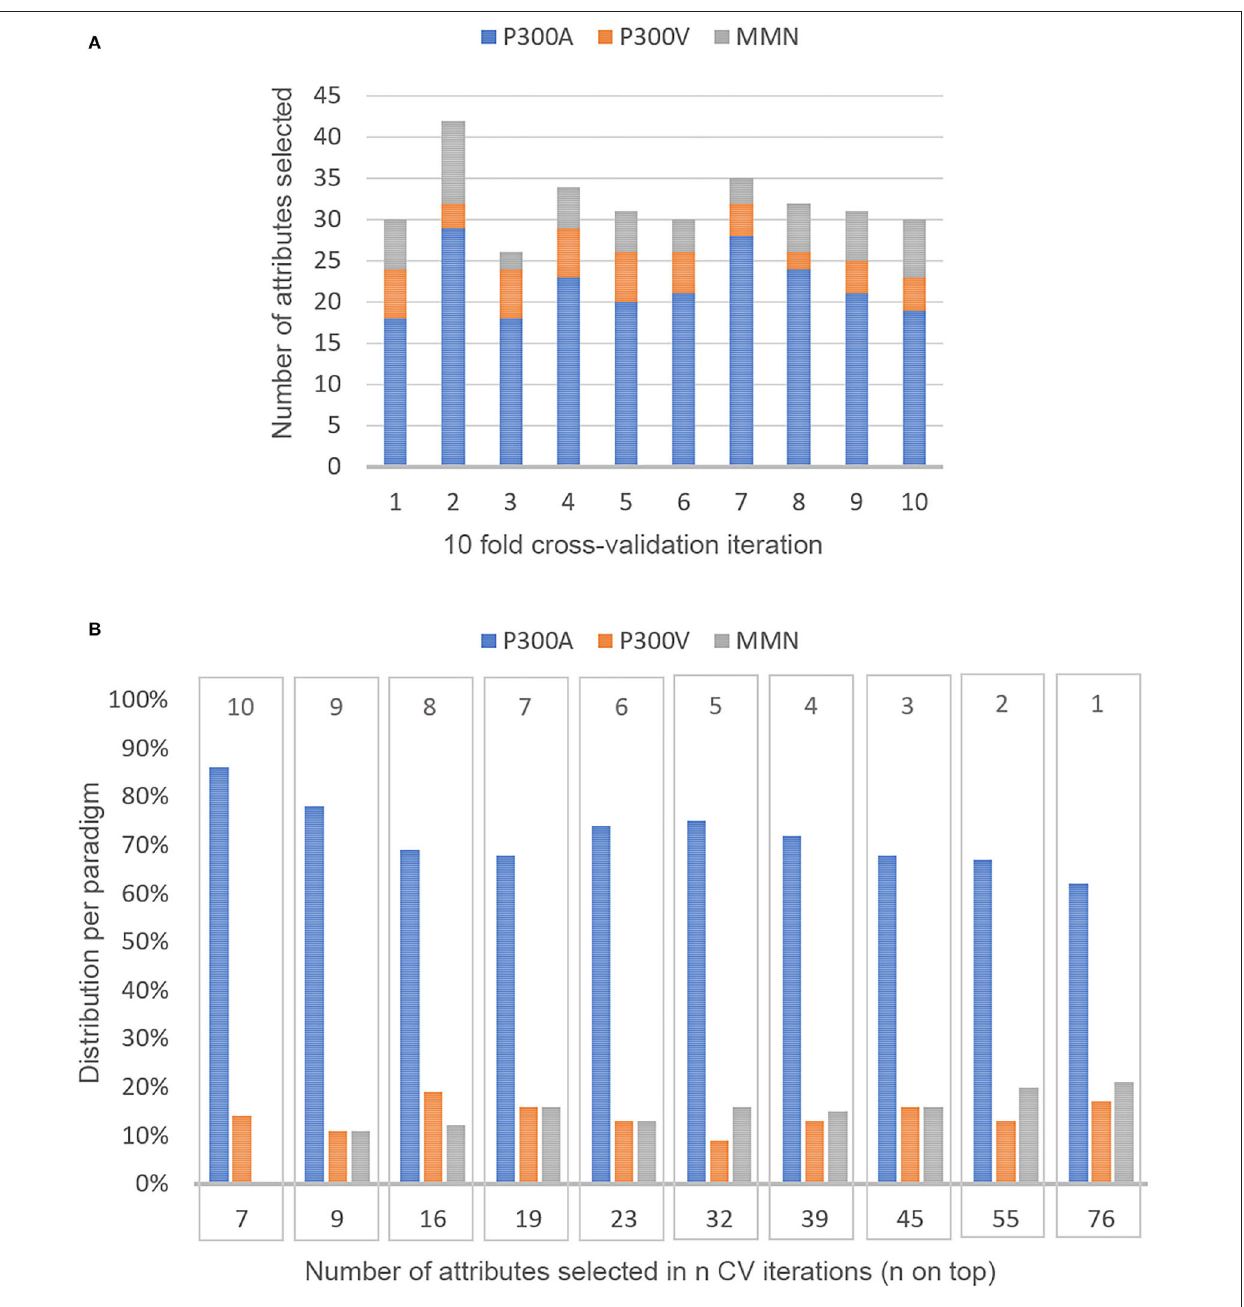
FIGURE 5 | Distribution of feature selection in 10 fold cross-validation. (A) Amount of attributes selected per k iteration of the 10 fold CV and the distribution per paradigm in the 10 subsets of features selected, (B) Frequency of selection of all the attributes that were selected at least once in the ten Boruta applications. The bottom number means how many features were selected at least in n CV iterations (n on